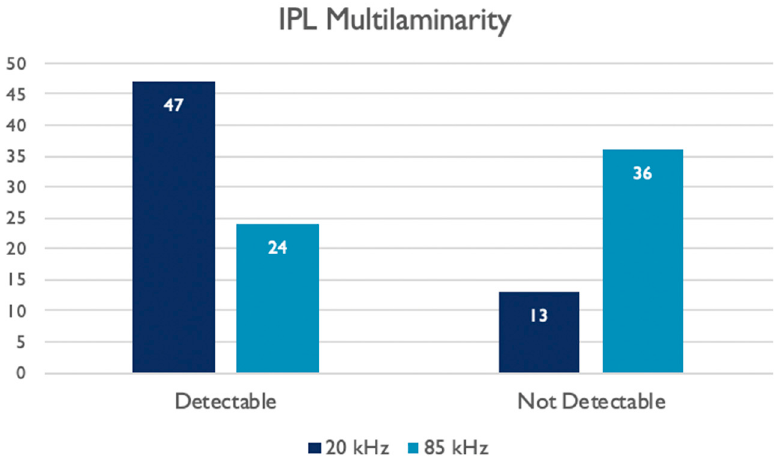
Table 5. Spearman’s correlation index (R) between the two matching retinal layers’ thickness measured with a 20 kHz and an 85 kHz A-scan rate in the foveal, nasal, and temporal areas. The bold values are statistically sigini fi cative ( p < 0.05) (RNFL: retinal nerve fi ber layer; GCL: ganglion cell layer; IPL: inner plexiform layer; INL: inner nuclear layer; OPL: outer plexiform layer; ONL: outer nuclear layer; ORL: outer retinal layer).